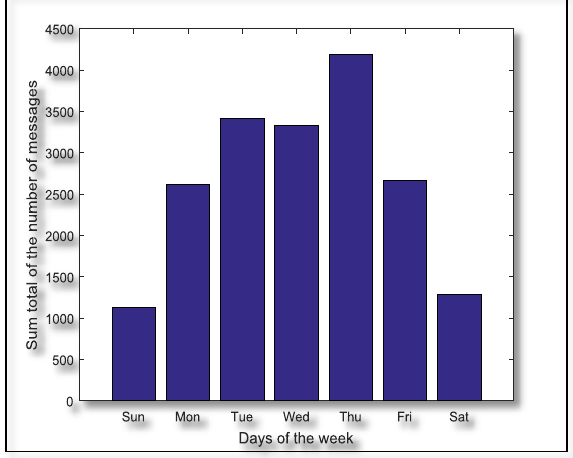
Figure 7: Sum total of the number of messages for each day of the week. Figure 7 indicates the number of tweets and Facebook posts made by commuters during the six-month study period. It is evident from the graph that most messages about the Gautrain were posted during the weekdays than they were during the weekends. This is most likely because most people use the Gautrain during the week for business purposes such as travelling between home and work as compared to using it for leisure purposes during the weekend. Such information is important as it has the potential to give an indication to company owners of the busiest day of the week. From this information, the operators will then know whether to increase staff or more trains on that particular day or